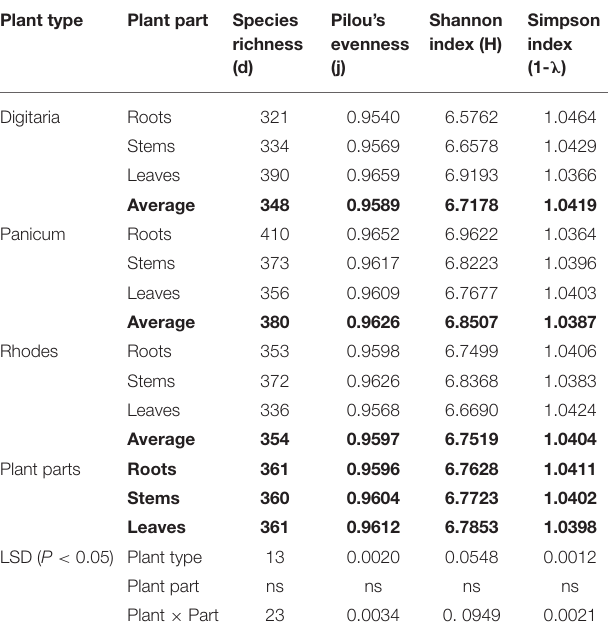
TABLE 2 | Diversity indices for nif H-gene harboring bacterial communities in different plant parts for different grass species. Plant type